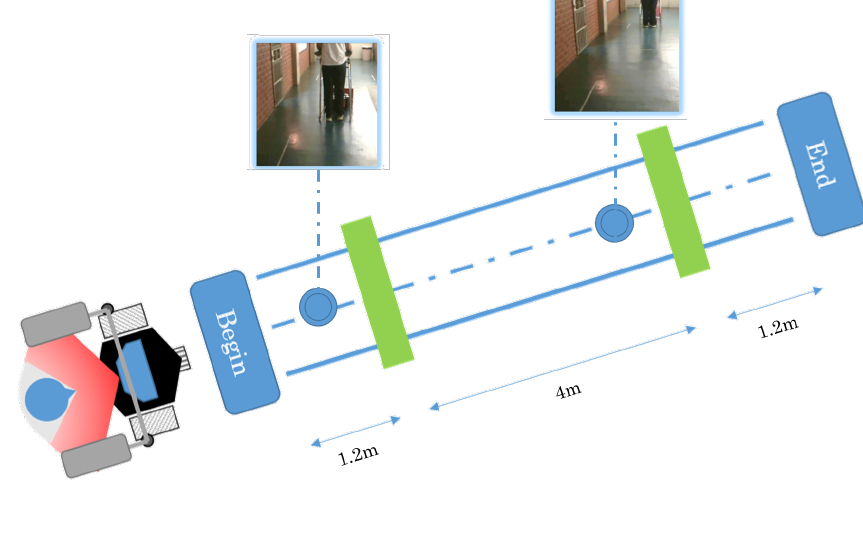
Figure 20. Diagram of the path with